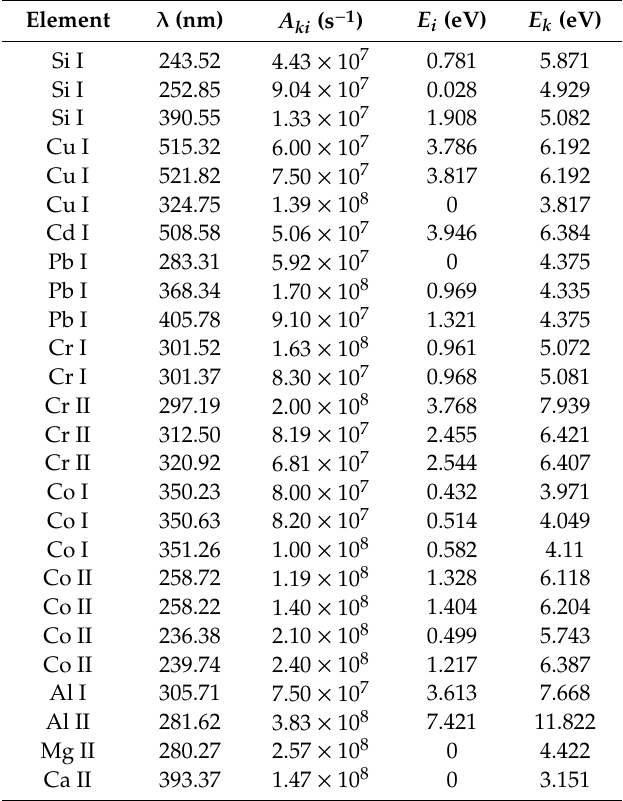
Table 3. Parameters of spectral lines used in the calibration curves ( λ —wavelength of spectral